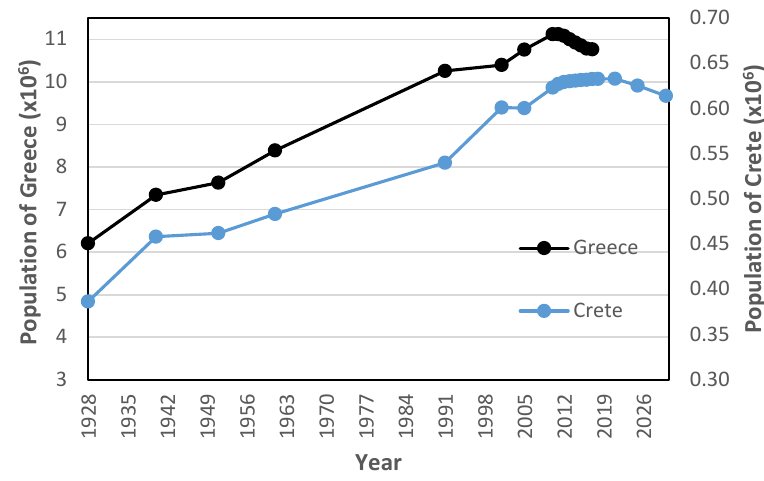
Figure 2. Evolution of the populations of Greece and Crete [33] .